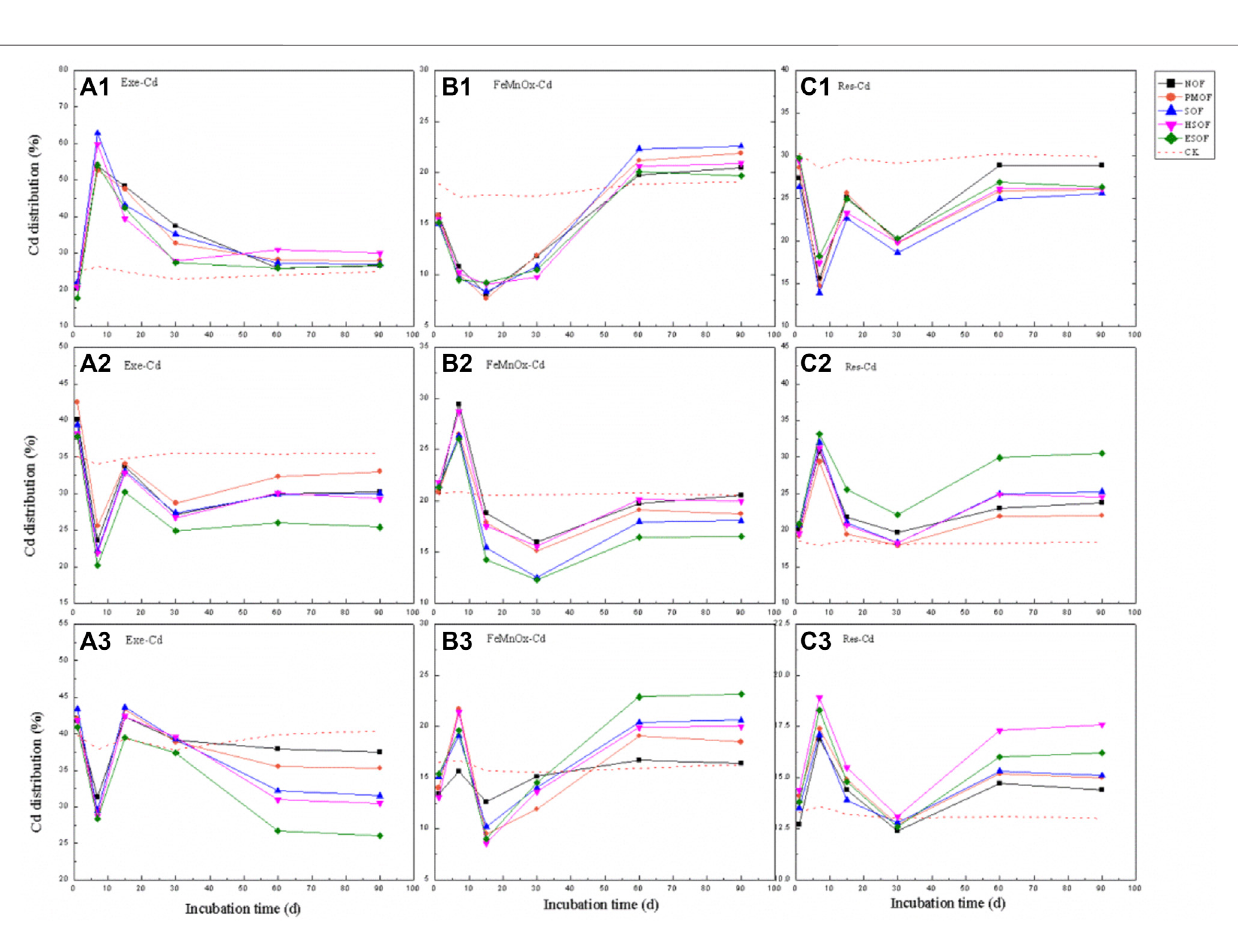
Frontiers in Environmental Science |